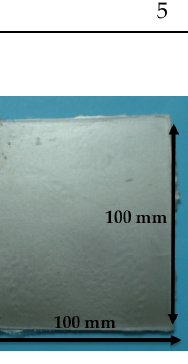
Figure 1. Aspect of the low density polyethylene (LDPE) sheet coated by a thin coating containing aluminum particles.